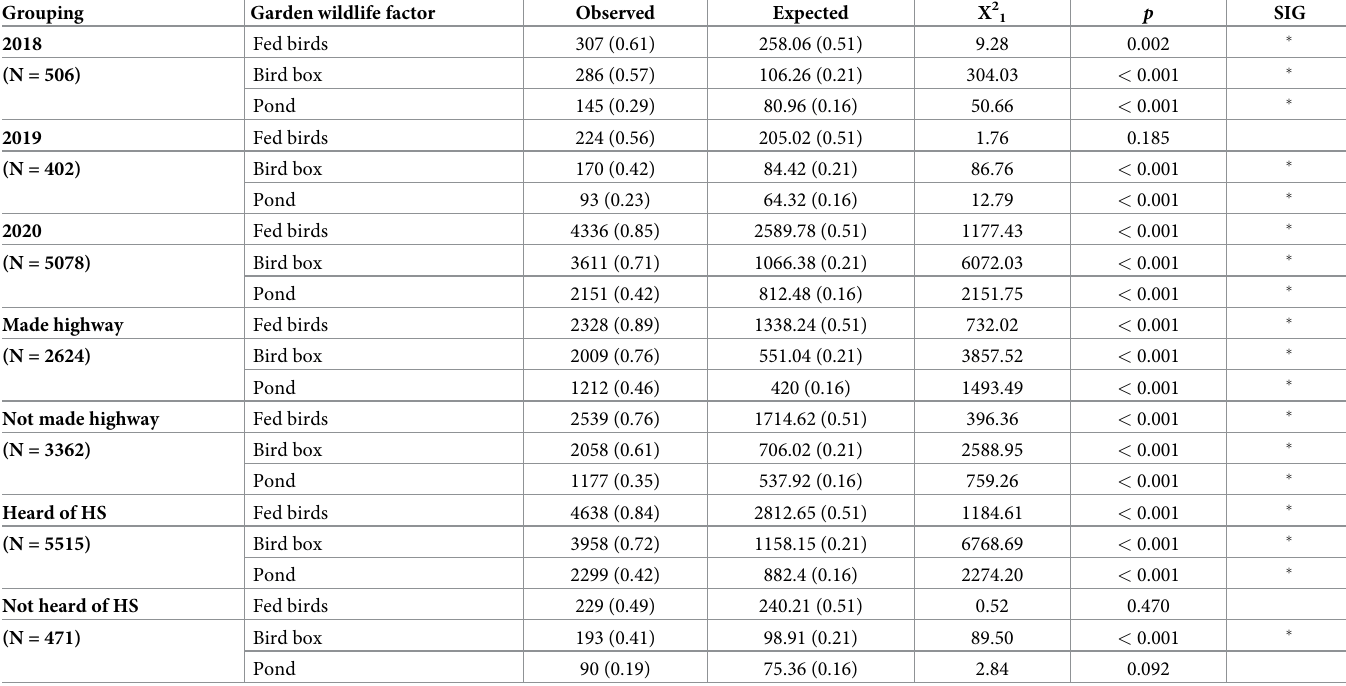
Table 2. Comparisons of the number of respondents (N = 5986) who (a) fed birds frequently, (b) had a bird box or (c) pond in their garden, relative to the estimates reported for the UK population by Davies et al . [25]. Grouping